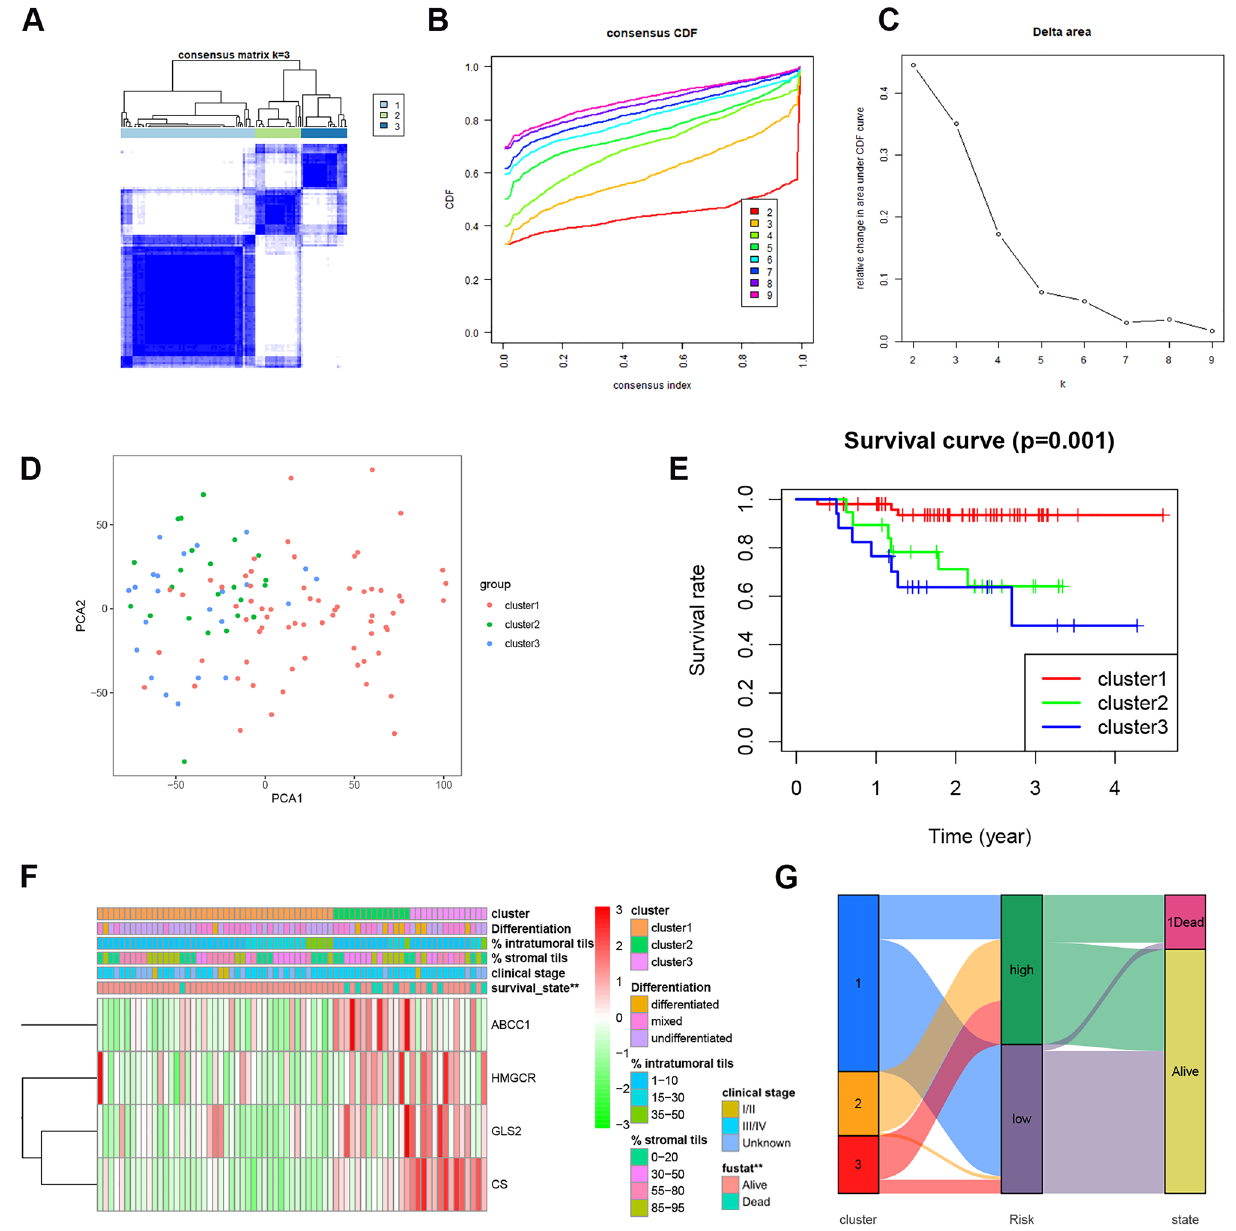
Figure 3. Consensus Clustering of FRGs of NPC. ( A ) Consensus clustering analysis using the R package “ConsensusClusterPlus” (https:// cran.r- proje ct. org/); ( B,C ) Consensus clustering cumulative distribution function; ( D ) PCA analysis for three clusters; ( E ) K-M curves of poor progression-free survival for three clusters; ( F ) The heatmap show the four clusters’ clinical characteristics of FRG. ( G ) Correlation analysis of clustering and risk classification using the R package “ggalluvial” and “ggplot2” (https:// cran.r- proje ct.